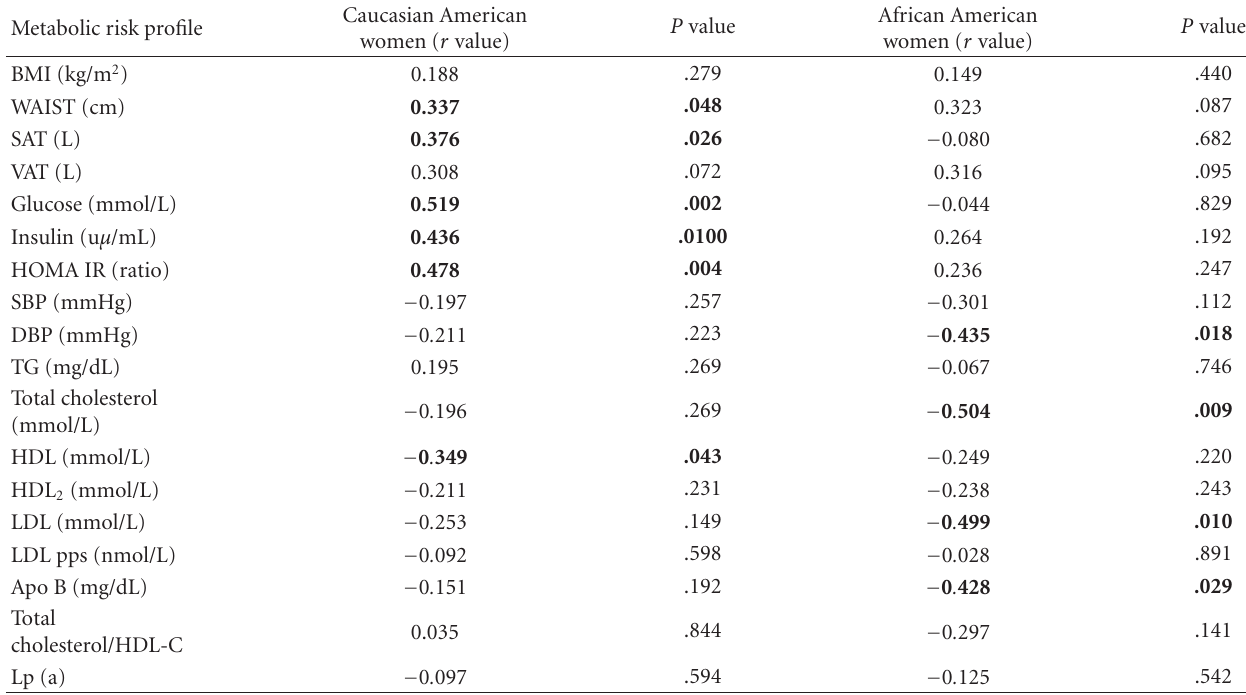
Table 3: Pearson correlation coe ffi cients between free androgen index (log transformed) and the metabolic risk profile after adjusting for